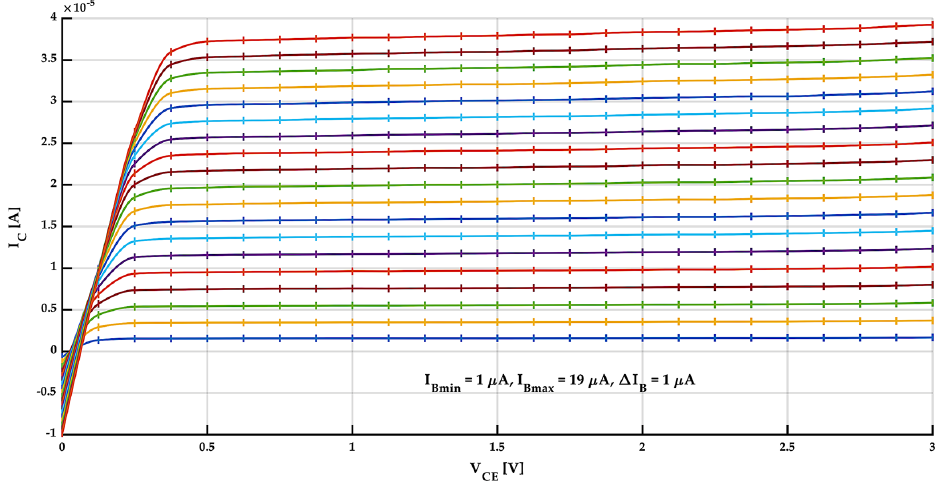
Figure 8. Example of the output characteristics, p-n-p device, and current gain factor = 7.38 (E-